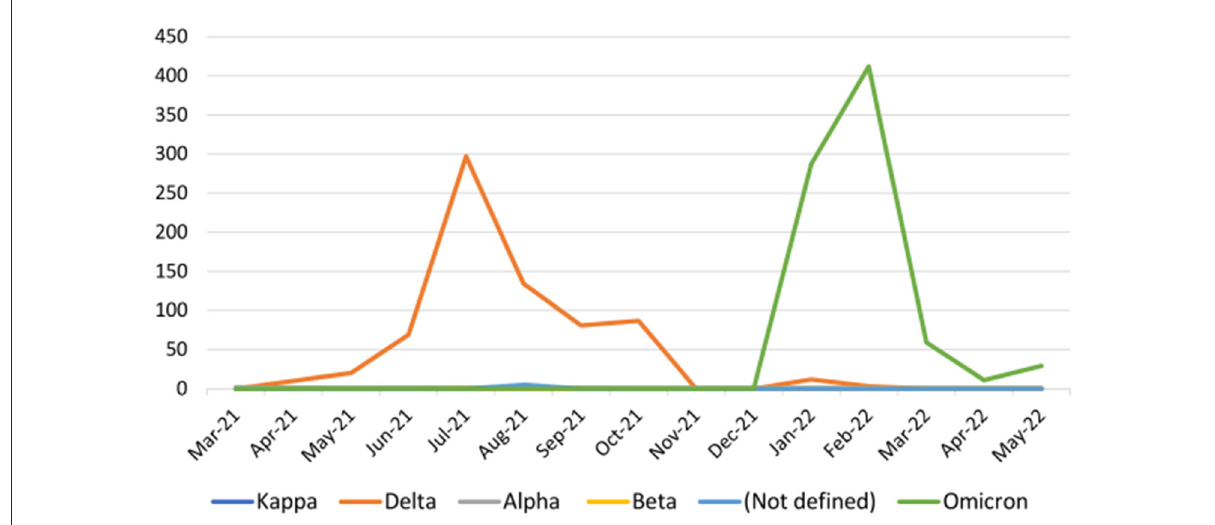
FIGURE1 The variants detected per month during the study period (samples received from March 2021 to May